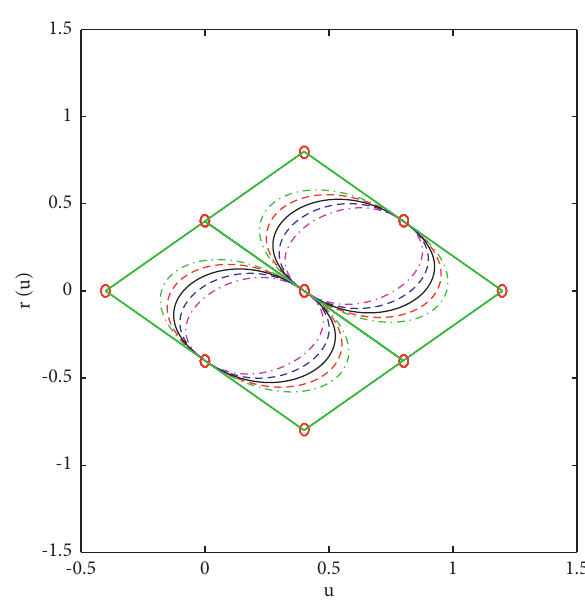
Figure 7: Closed curve using